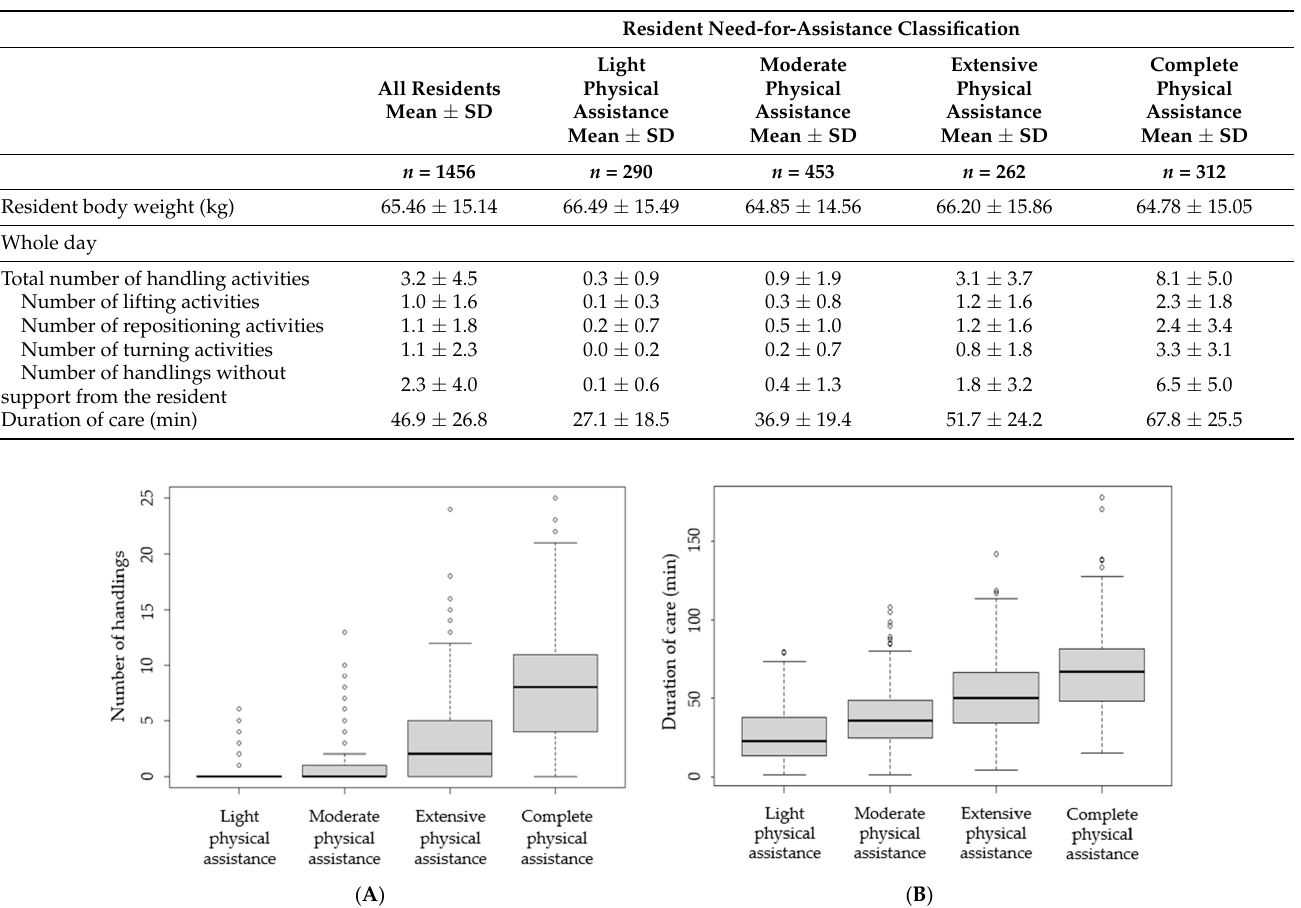
Table 1. Descriptive results of the residents’ observed need for physical assistance according to the resident need-for-physical-assistance scale.